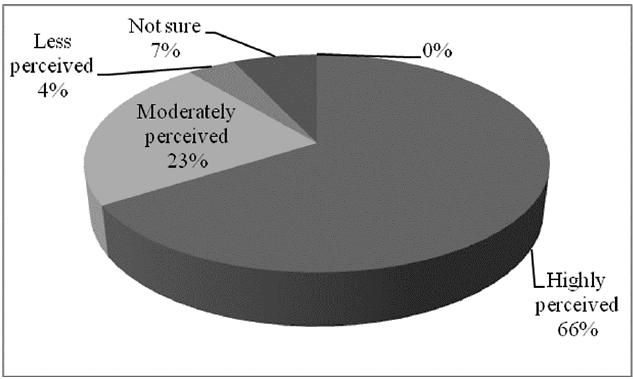
Figure 1. Levels of climate change risk perceptions of farmers in Lawra district.